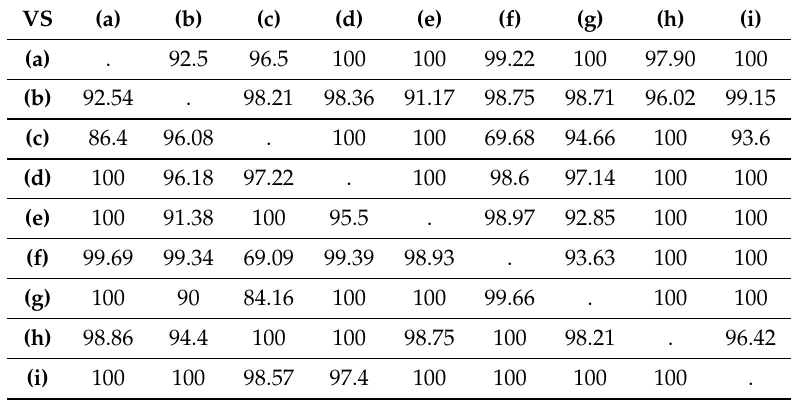
Table 2. Results of the automatic individual verification algorithm’s discarding evaluation performance (%).